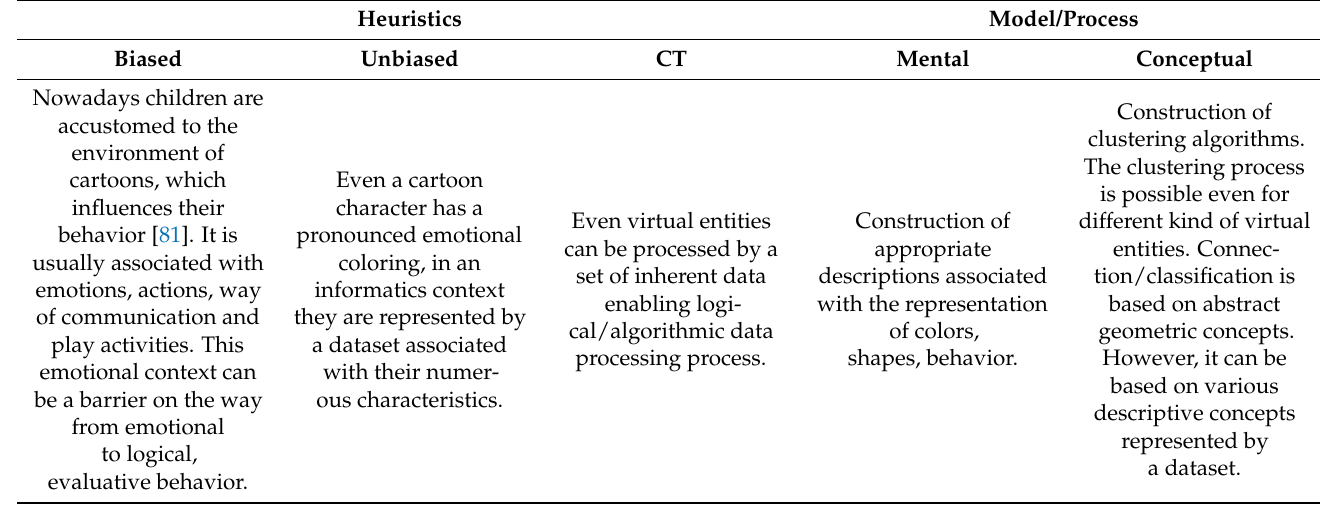
Figure 6. A sample of the Bebras short task on pattern matching for pre-primary level (age 5–8). Retrieved with permission from www.bebras.org (accessed on 24 February 2022). Table 2. A case of the Bebras short task on pattern matching aimed at scaffolding CT mindset (elaborated by the authors).